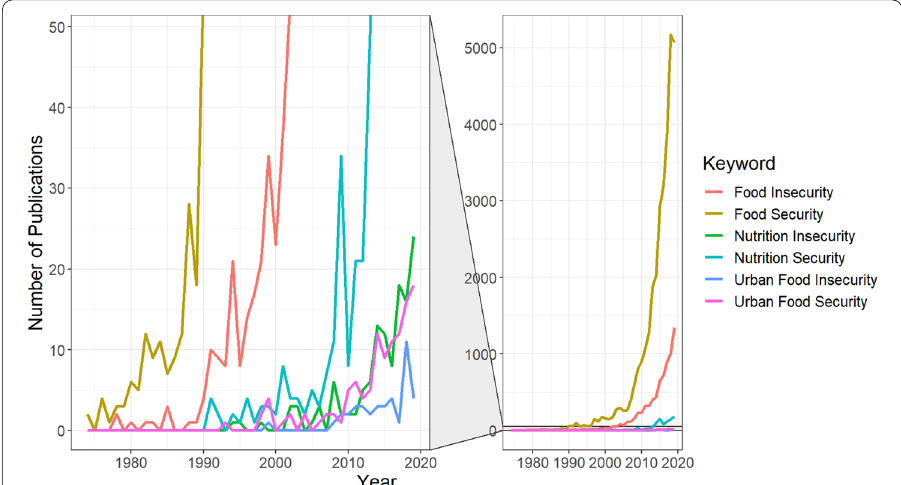
Fig. 1 Number of publications on Web of Science and Scopus for each topic (figure on the right is an enhanced image of the relevant section of the image on the